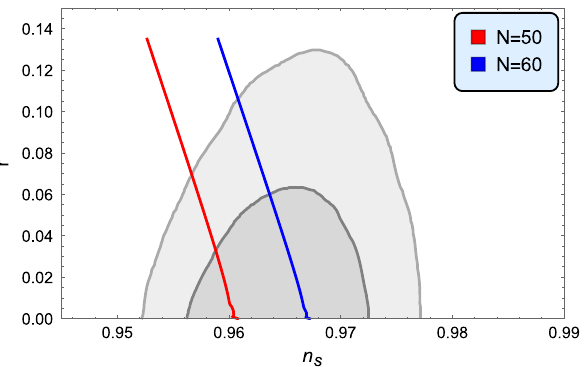
value S i = 15 . 3542 M Pl and final value S e = 3 . 13524 M